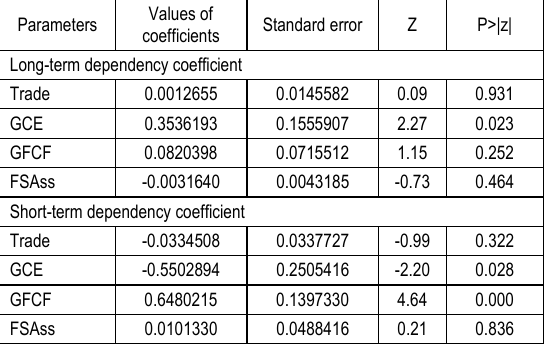
Table 16. The results of PMG approach to determining short-term and long-term coefficients of dependency between imbalances in the movement of financial resources (FSAss indicator) and economic growth for the sample of surveyed countries